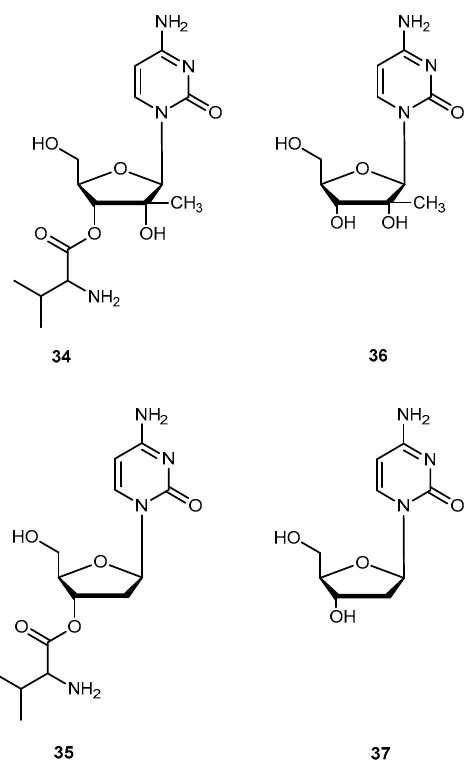
Figure 16. Ester prodrugs 34 , 35 of 36 and 37 respectively.